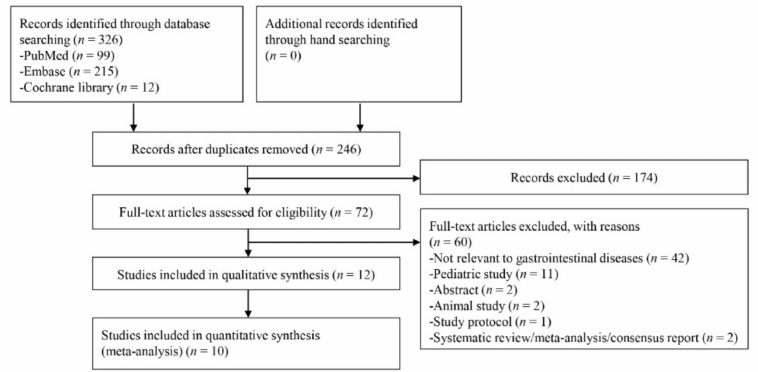
Figure 1. Flow diagram of study